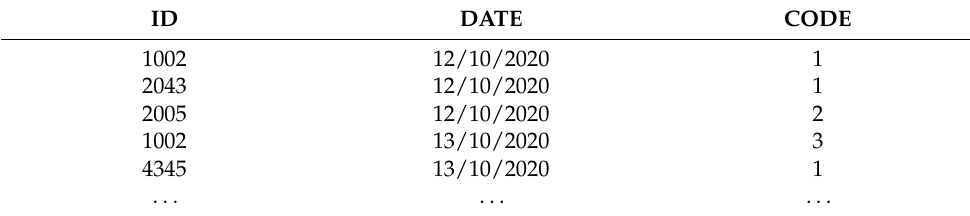
Table 1. An illustrative example of a health records